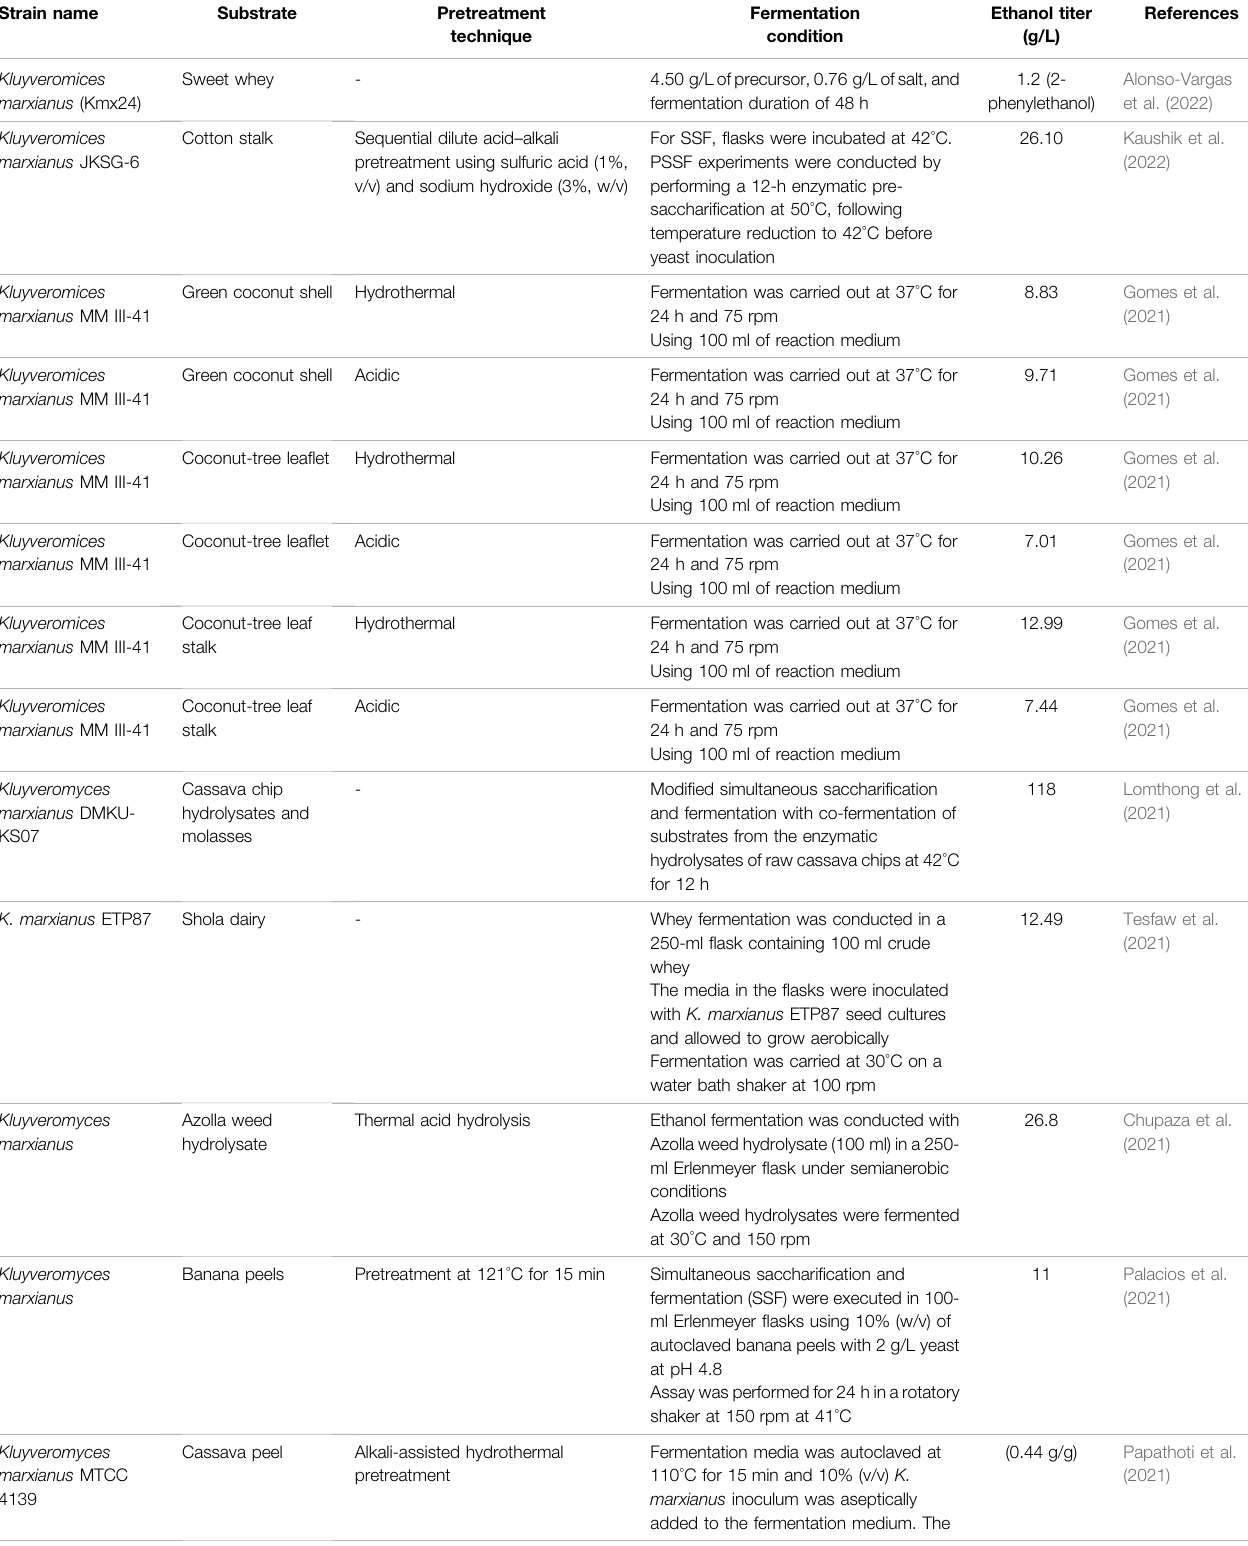
TABLE 2 | Summary of ethanol production by various Kluyveromyces marxianus